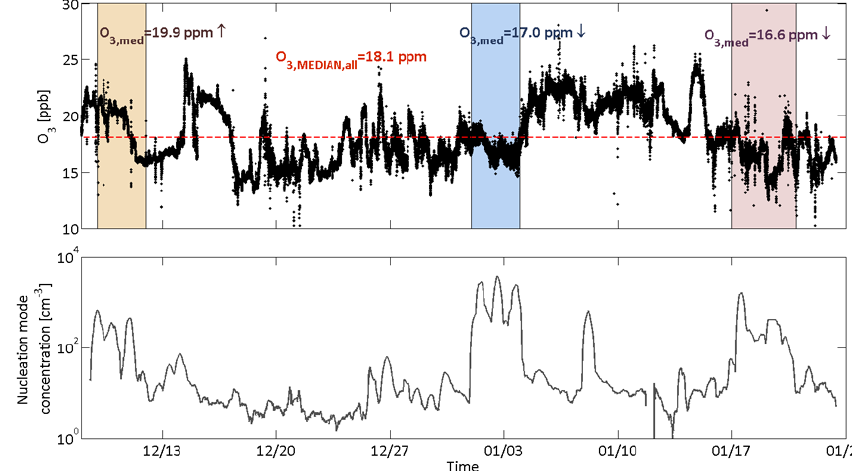
Fig. 10. Ozone concentration (A) and nucleation mode concentration (B) during the entire campaign. The event periods are shaded with light yellow (9 to 11 December 2009), light blue (1 to 3 January 2010) and pink (17 to 20 January 2010). The median ozone concentration during the campaign is marked with a red line.